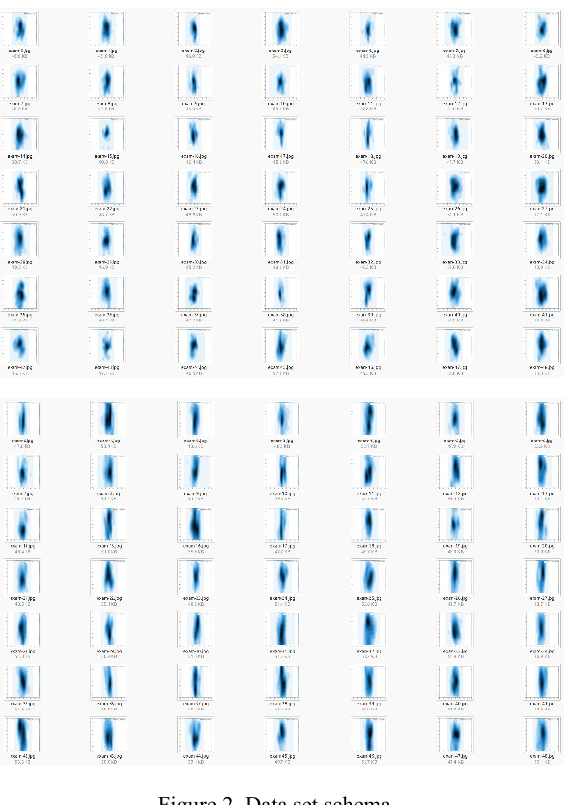
Figure 2. Data set schema